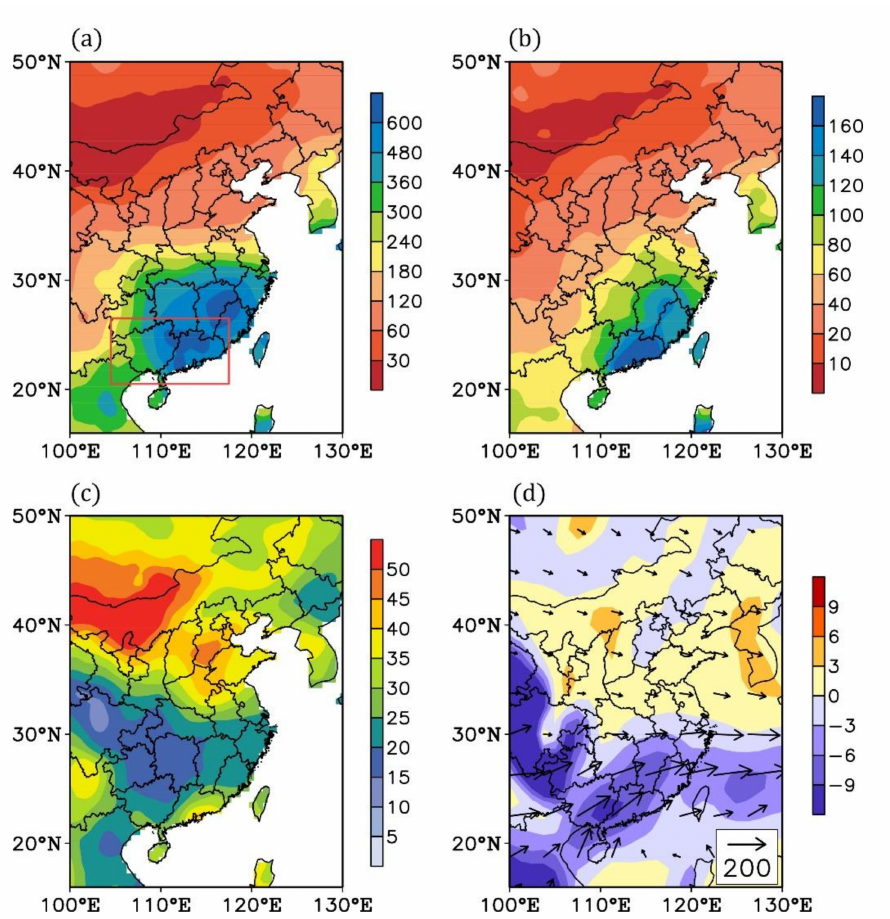
Figure 1. ( a ) Total precipitation (units: mm) in spring (March, April, and May) for the period 1958–2019. The red box denotes the South China area. ( b ) Standard deviation of spring precipitation (units: mm) during 1958–2019. ( c ) Proportion (units: %) of the standard deviation of precipitation in total precipitation in spring during 1958–2019. ( d ) Mean water vapor flux (arrows; units: kg m − 1 s − 1 ) integrated from 300 to 1000 hPa and its divergence (colors; units: 1e 5 kg m − 2 s − 1 ) in spring during